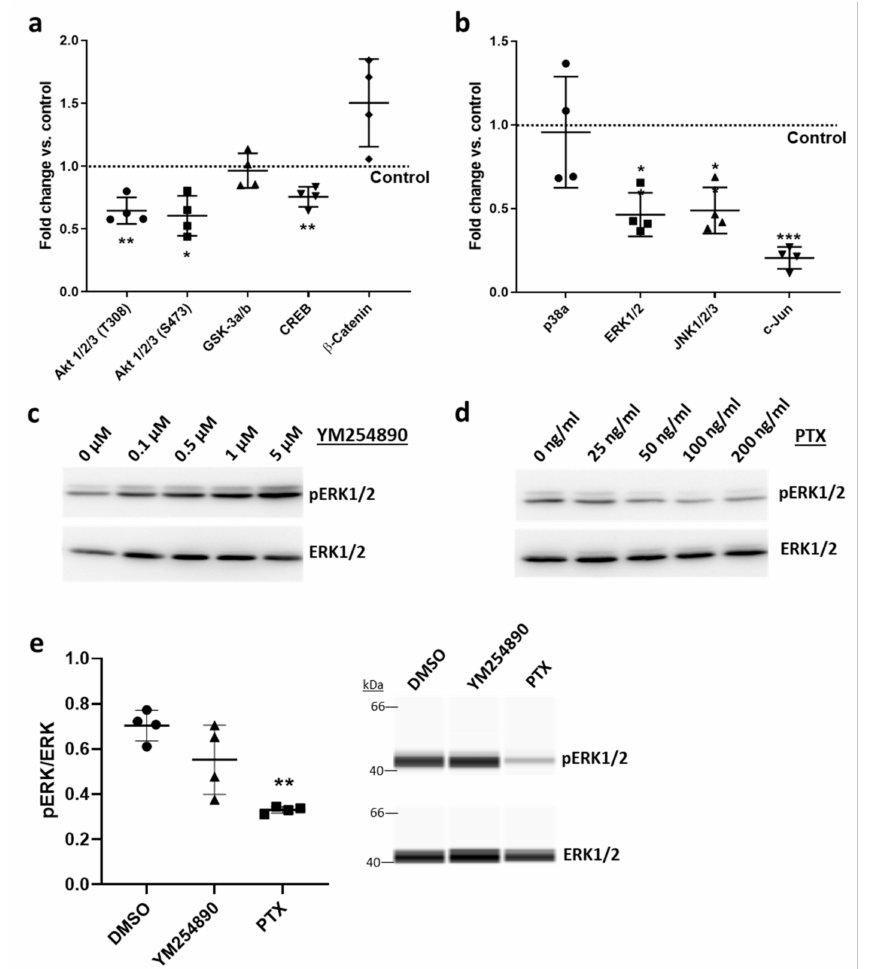
Figure 6. RGS5 overexpression in human VSMCs inhibits the activity of several kinases. ( a , b ) The phosphorylation level of different protein kinases and some of their targets in HUASMCs overex- pressing GFP (Control) or RGS5 was assessed by applying a protein kinase profiler array (* p < 0.05, ** p < 0.01, *** p < 0.001 vs. Control, n = 4). ( c – e ) Immunoblot-based analyses of ERK1/2 phos- phorylation (pERK1/2) in HUASMCs treated with either G α q/11 inhibitor (YM254890) or G α i/o inhibitor (Pertussis Toxin, PTX) for 24 h. ( c , d ) Concentration-dependent effect of YM254890 and PTX on ERK1/2 phosphorylation. ( e ) Capillary electrophoresis-based immunodetection of pERK1/2 and ERK1/2 in HUASMC after 24 h treatment with 2 µ M of YM254890 and 200 ng/mL of PTX, respectively (** p < 0.01 vs. DMSO solvent control, n =